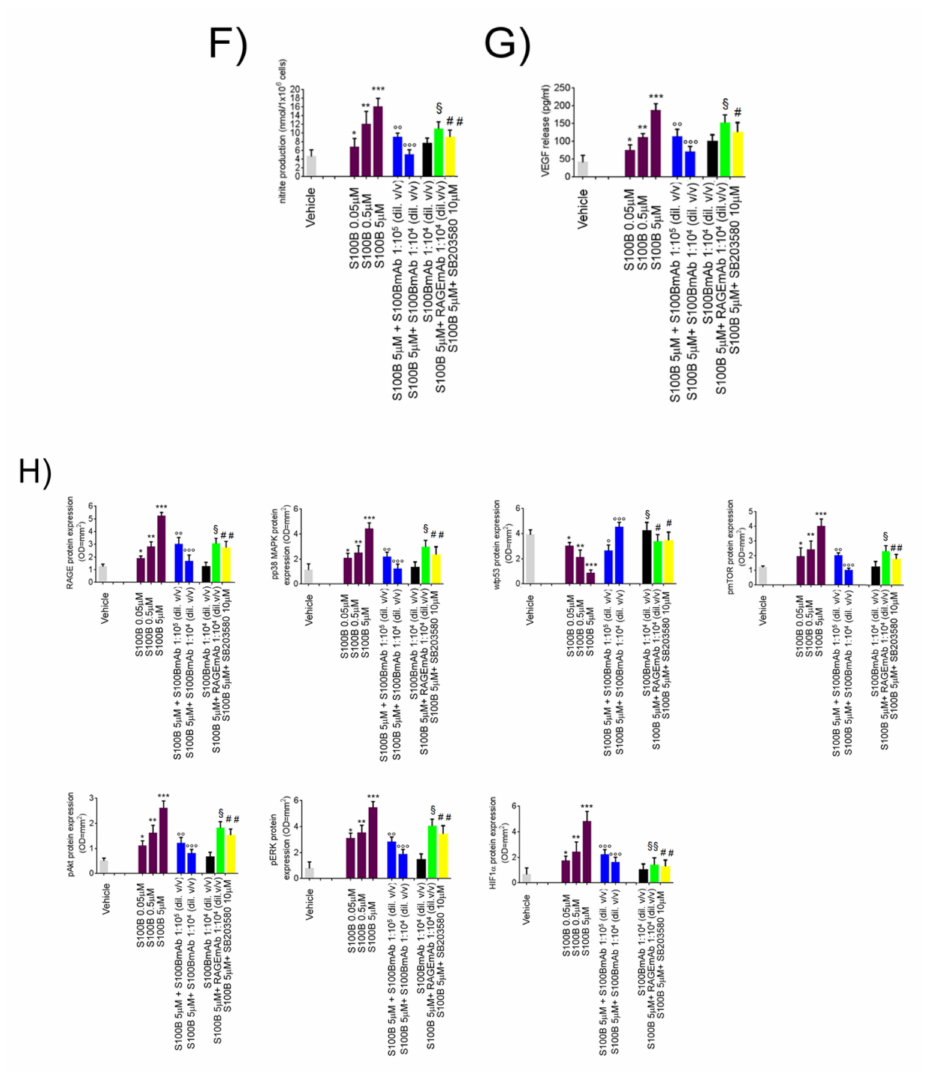
Figure 2. S100B stimulates pro-angiogenic vascular endothelial growth factor (VEGF) and NO release through Akt / mammalian target of rapamycin (mTOR) pathways and relative molecular downstream regulation by S100BmAb. ( A ) Immunoreactive bands referred to RAGE, phosphorylated / unphosphorylated-p38MAPK, phosphorylated / unphosphorylated Akt, phosphorylated ERK / unphosphorylated ERK, phosphorylated / unphosphorylated-mTOR, wild type (wt)p53, hypoxia-induciblefactor1-alpha(HIF1 α )proteinexpressionand( H )theirrelativedensitometric analysis (arbitrary units normalized on the expression of the housekeeping protein β -actin, showing the e ff ect of S100B (0.05–5 µ M) in the presence of S100BmAb (1:10 5 –1:10 4 v / v diluted) at 24 h, S100BmAb alone (1:10 4 v / v diluted) or S100B 5 µ M in the presence of, respectively RAGEmAb (1:10 4 v / v diluted) or SB203580 (10 µ M). ( B ) Immunofluorescence analysis showing inducible nitric oxide-synthase (iNOS; green), VEGF-R1 and ( C ) VEGF-R2 (red) and ( D ) Ki67 (red) immunoreactivity with ( E ) the relative quantification of iNOS (green bars), VEGF-R1 (yellow bars) VEGF-R2 (red bars) and Ki67 (blue bars) protein expression in Caco-2 cells treated with S100B (5 µ M) in presence or absence of S100BmAb (1:10 4 v / v diluted), or RAGEmAb (1:10 4 v / v diluted) and SB203580 (10 µ M). In the same experimental conditions, ( F and G ) quantification of nitrite and VEGF levels respectively in the supernatant media of Caco-2 cells exposed to the same treatment. Results were expressed as mean ± SEM of n = 6 experiments performed in triplicate.* p < 0.05; ** p < 0.01 and *** p < 0.001 versus vehicle; ◦ p < 0.05, ◦◦ p < 0.01 and ◦◦◦ p < 0.001 versus S100B 5 µ M; # p < 0.05 ## p < 0.01; § p < 0.05 and §§ p < 0.01, respectively versus S100B 5 µ M-treated cells. Scale bar: 10 µ m; Magnification